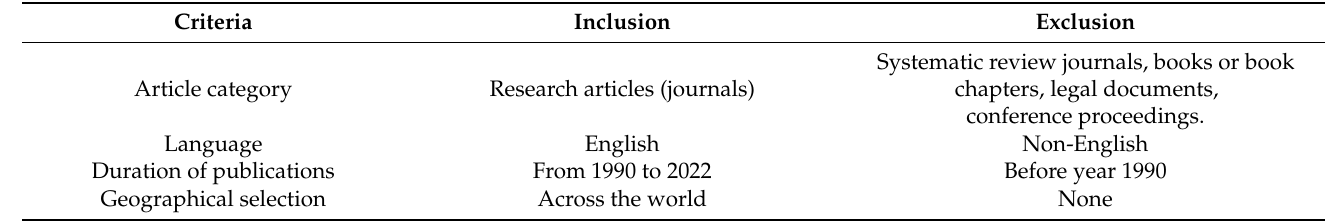
Table 3. Inclusion and exclusion